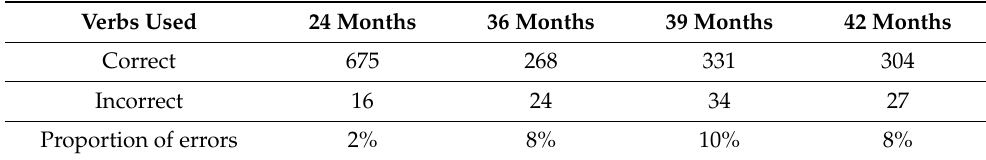
Table 12. Verbs in children’s speech.